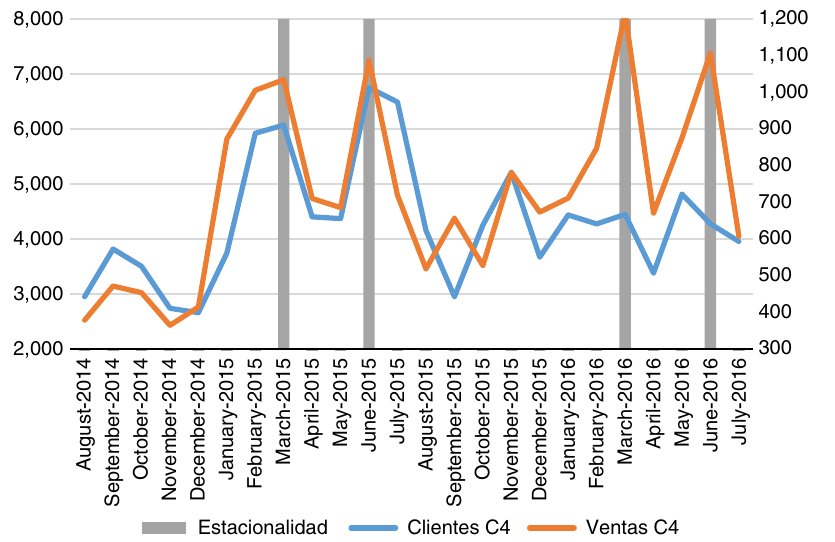
Figure 1. Representation of the seasonality of the sales and clients assisted